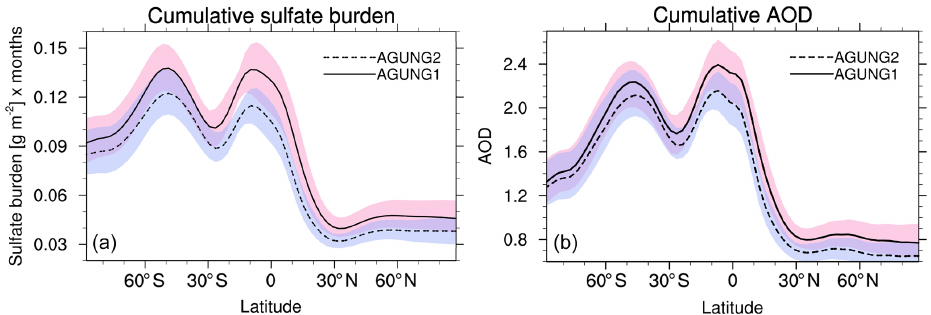
Figure 3. Cumulative values, integral over 21 monthly mean values, of (a) zonally averaged sulfate burden and (b) AOD at 550nm. The shadings indicate the maximum and minimum values of the single simulations in the ensemble.